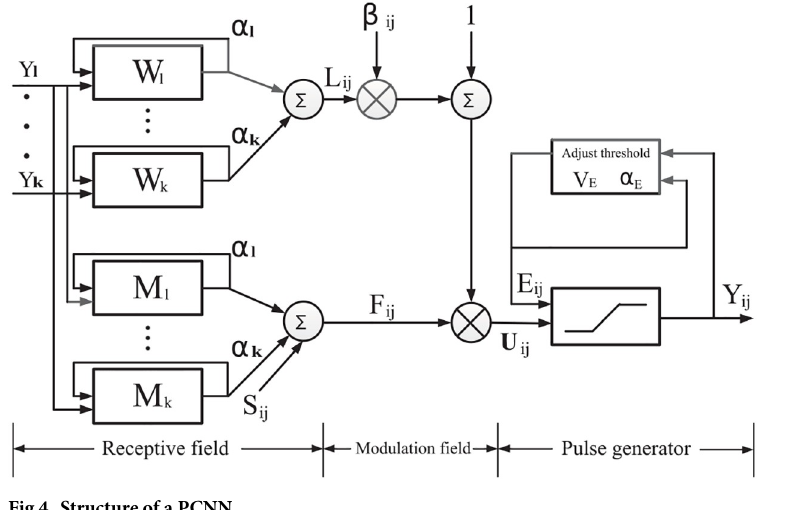
Fig 4. Structure of a